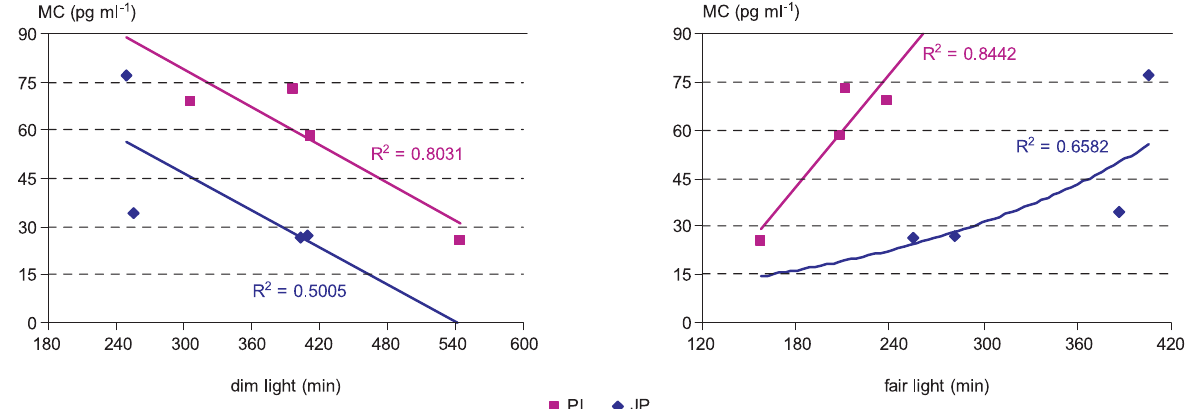
Fig. 6. Statistical relationships between observed daytime (from 7 a.m. till 7 p.m.) totals of time the subjects were exposed to dim light (<50 lux) and fair light (51–500 lux) and the highest night melatonin concentration (MC) at Japanese (JP) and Polish (PL)